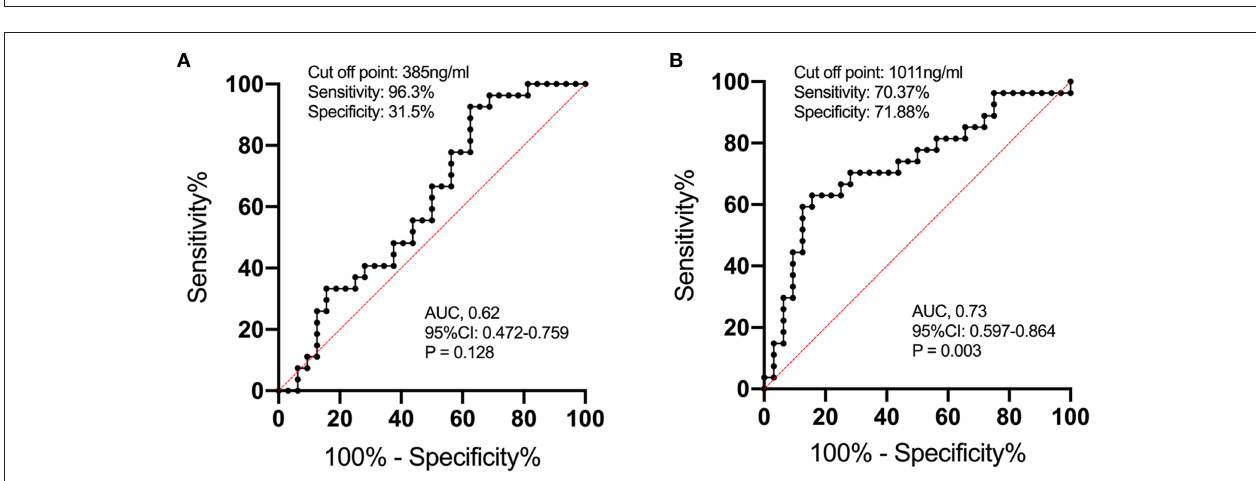
FIGURE 4 | The ROC curve analysis of serum MMP-2 (A) and MMP-9 (B) concentrations for predicting the occurrence of spontaneous hemorrhage in MMD. The ROC curve identified that serum MMP-9 levels > 1,011ng/ml may predict the occurrence of spontaneous hemorrhage in adult patients with MMD with 70.37% sensitivity and 71.88% specificity [area under curve (AUC), 0.73; 95% CI 0.597–0.864; P = 0.003].